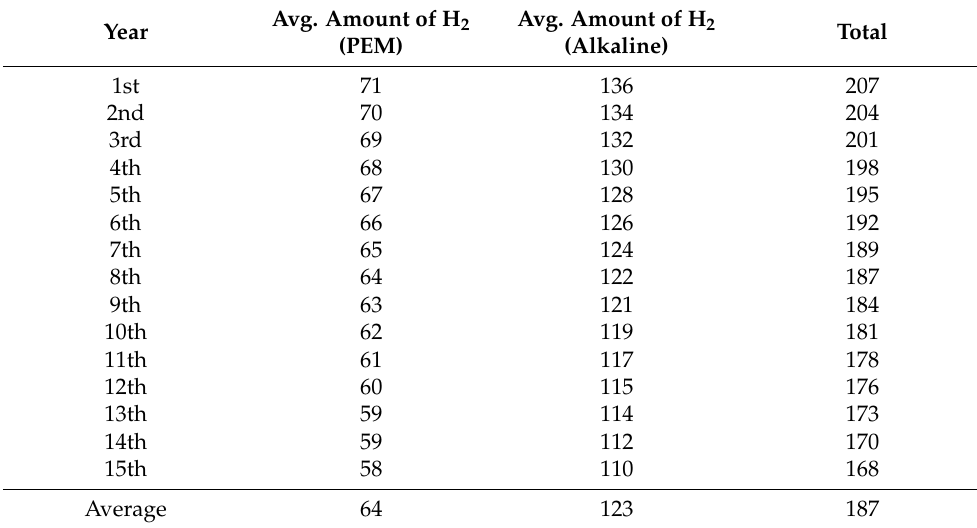
Table 23. The average daily amount of hydrogen produced for each year (Scenario